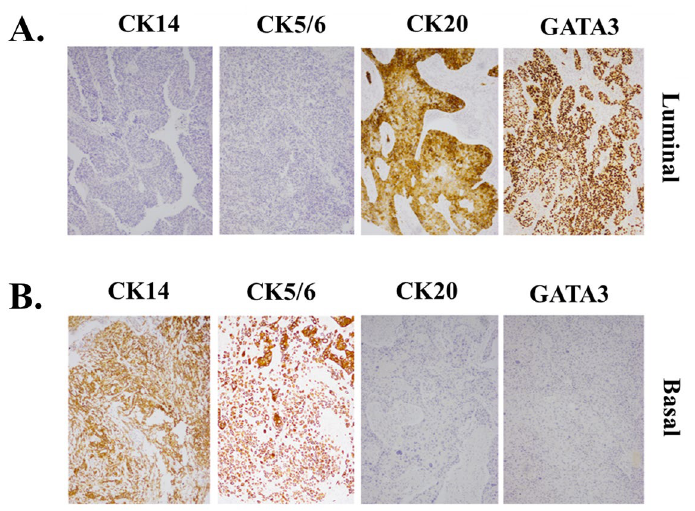
Figure 1. Immunohistochemical staining of MIBC tissues for GATA3, CK20, CK5/6, and CK14. ( A ) Luminal type, ( B ) Basal